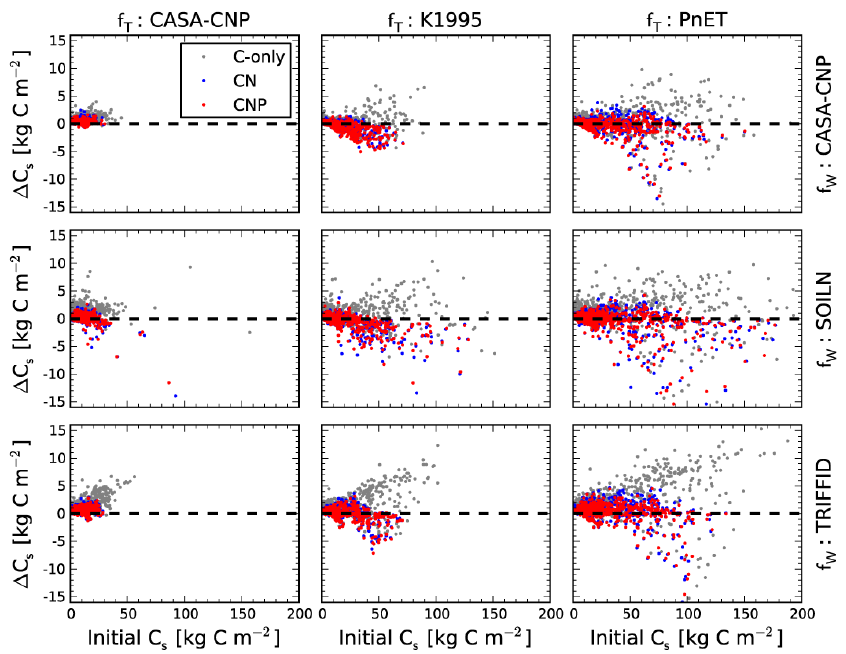
Fig. 9. Change in soil carbon C s as a function of initial value for all grid boxes for all simulations in C-only, CN and CNP modes as